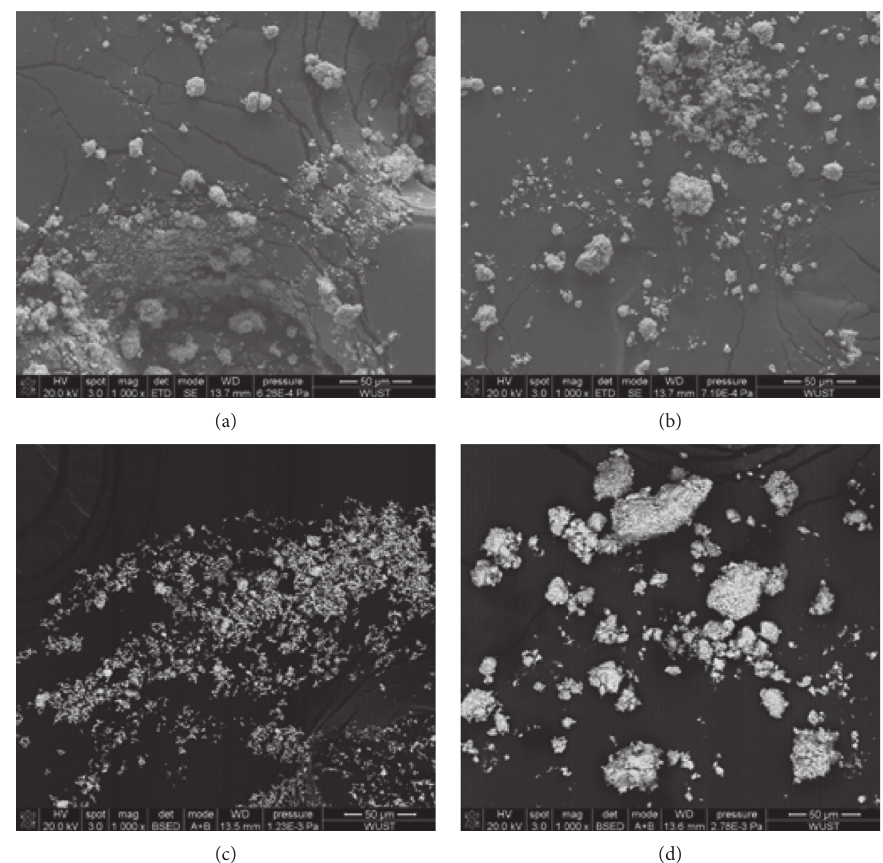
Figure 2: Secondary electron images (SEI) in SEM of the milled powders with different milling time; (a) for 0h, (b) for 0.5h, (c) for 2h, (d) for 10h.